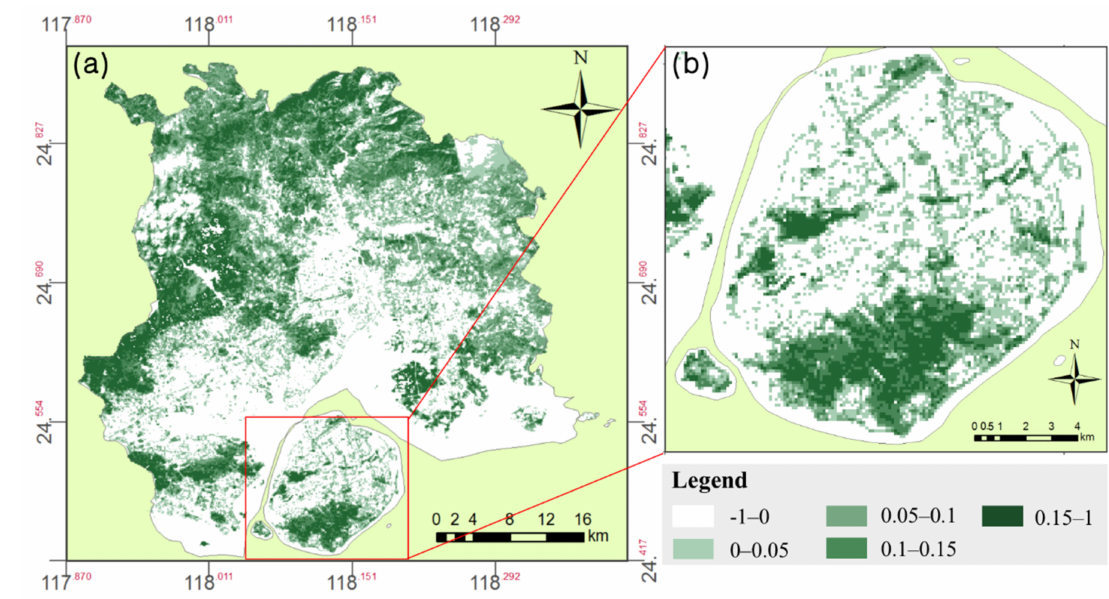
Figure 11. ( a ) Greenspace grids; and ( b ) zoomed-in area of the red